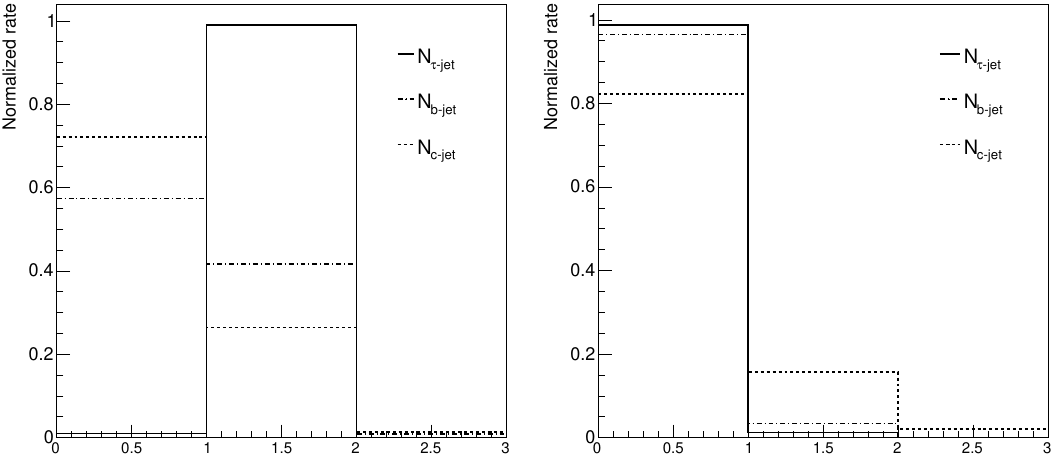
= 1 and backgrounds. Events are restricted V LL > 100 GeV. T